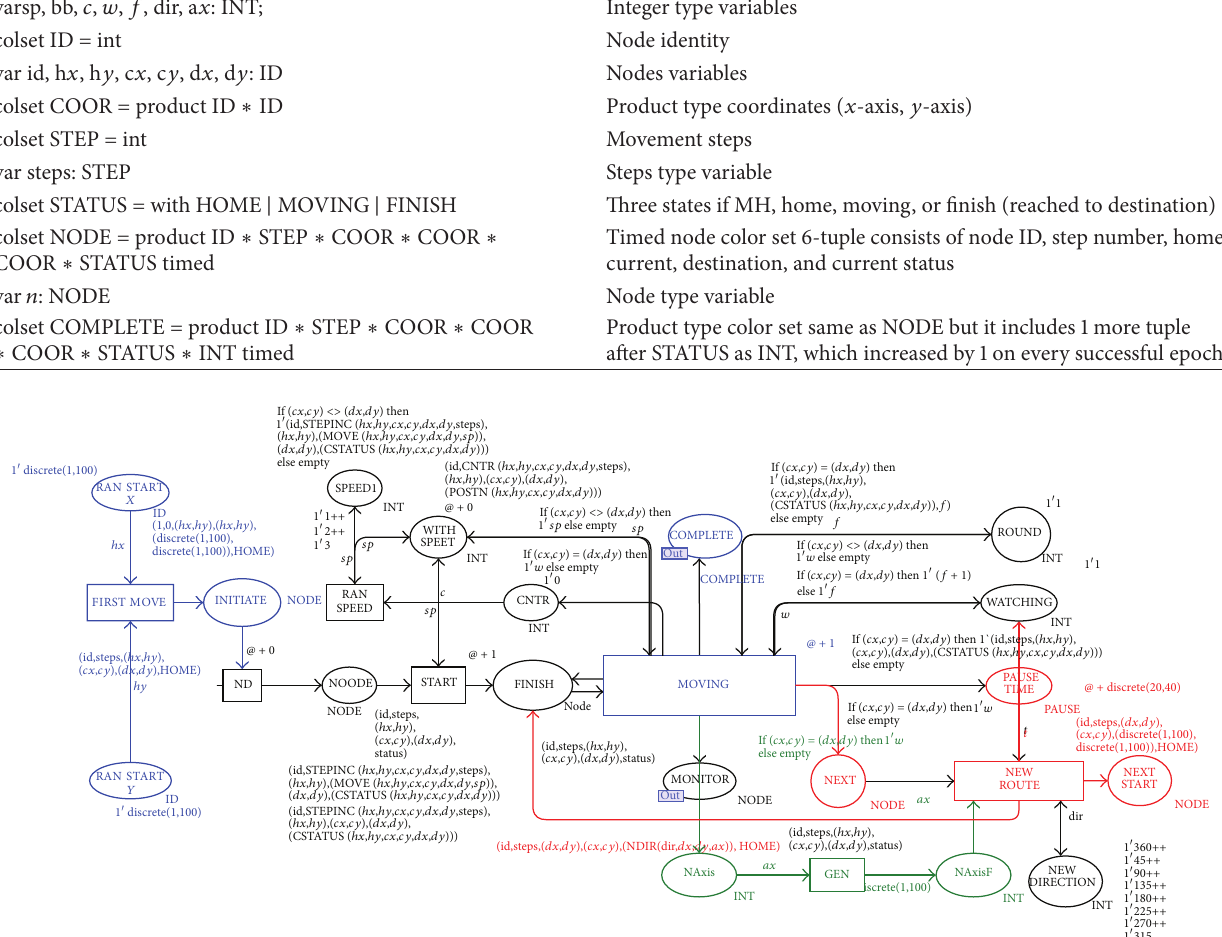
Figure 4: The CPN model of RWP mobility